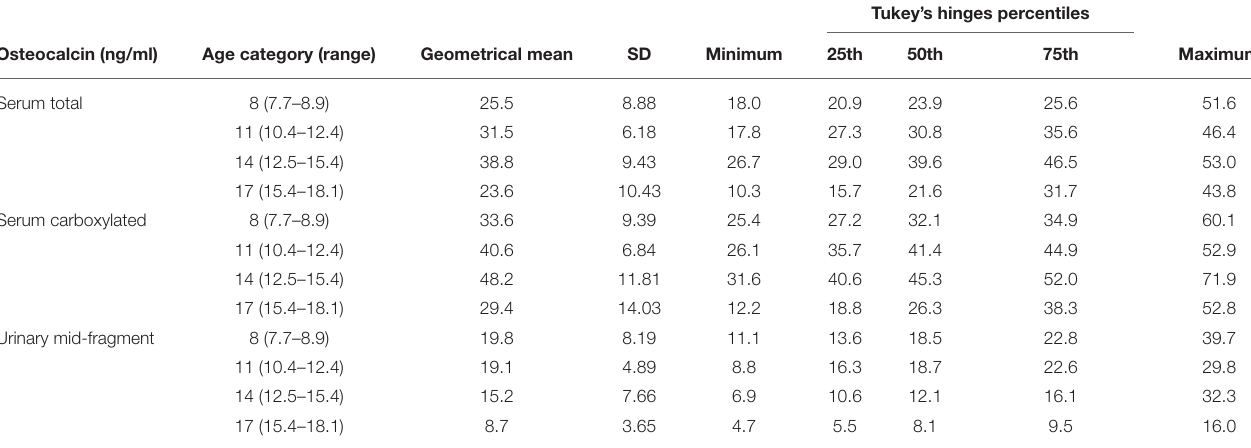
Tukey’s hinges percentiles